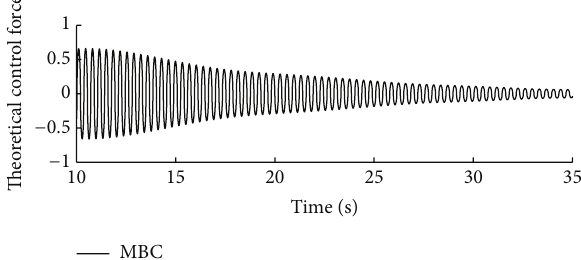
Figure 8: Control force time-history response curve.